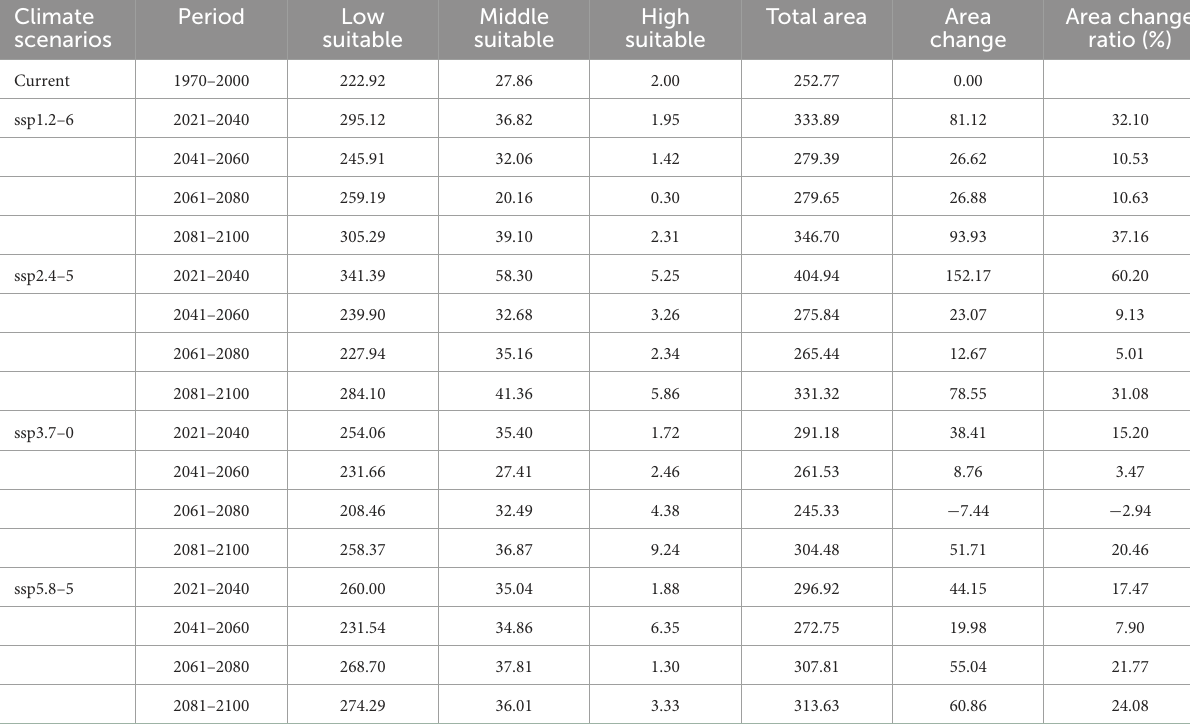
TABLE 2 Suitable areas of P. hesperomys in China under current and future climate scenarios ( × 10 4 km 2 ). Climate